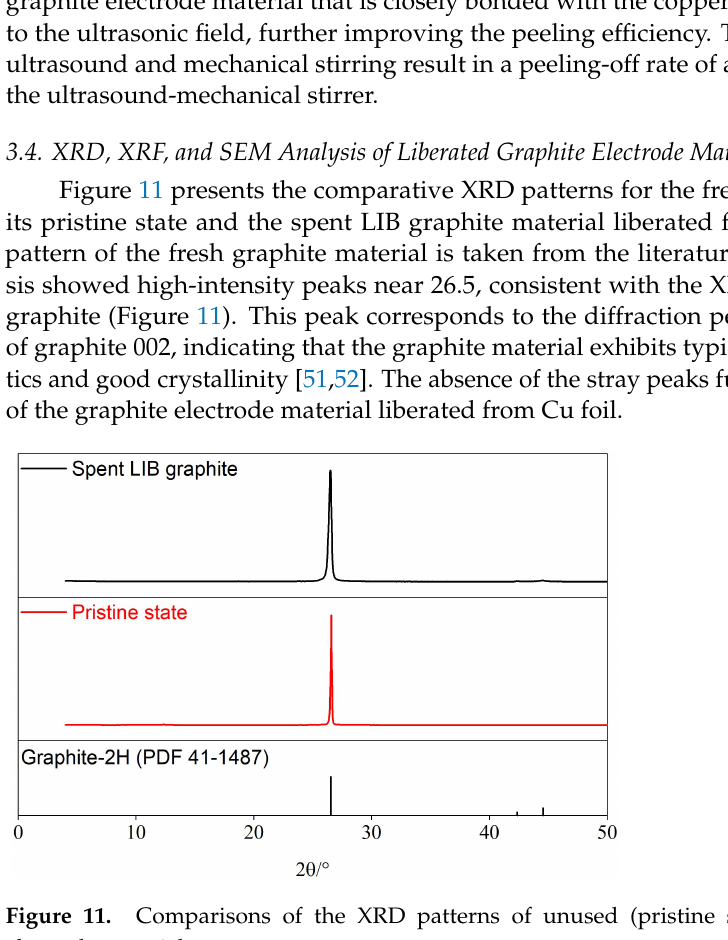
Table 1. XRF analysis of the liberated graphite electrode material (Wt. %).